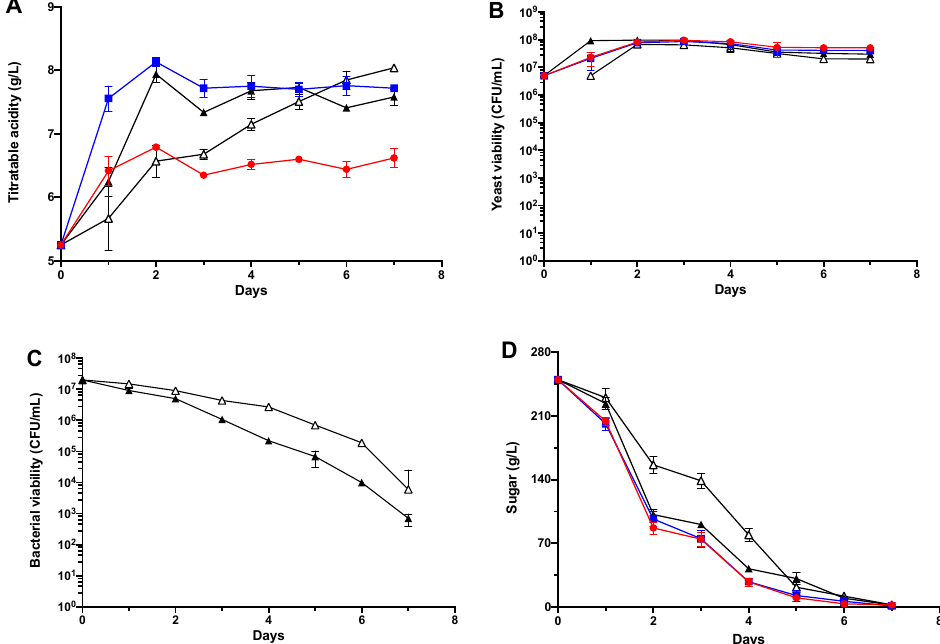
Figure 1. Fermentation and acidification kinetics in the Cabernet Sauvignon pilot-scale vinification. ( A ) Sugar consumption kinetics; ( B ) Yeast viability; ( C ) LP population; ( D ) Trends in total titratable acidity during fermentation. D-SC ( ), TA-SC ( ), S-LP ( ), PreAF-LP ( ).